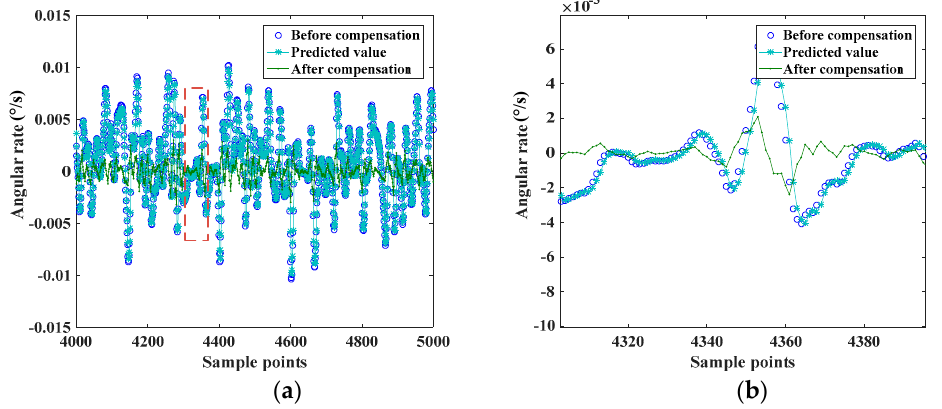
Figure 12. ( a ) The change of random drift before and after compensation; ( b ) partially enlarged detail of ( a ).